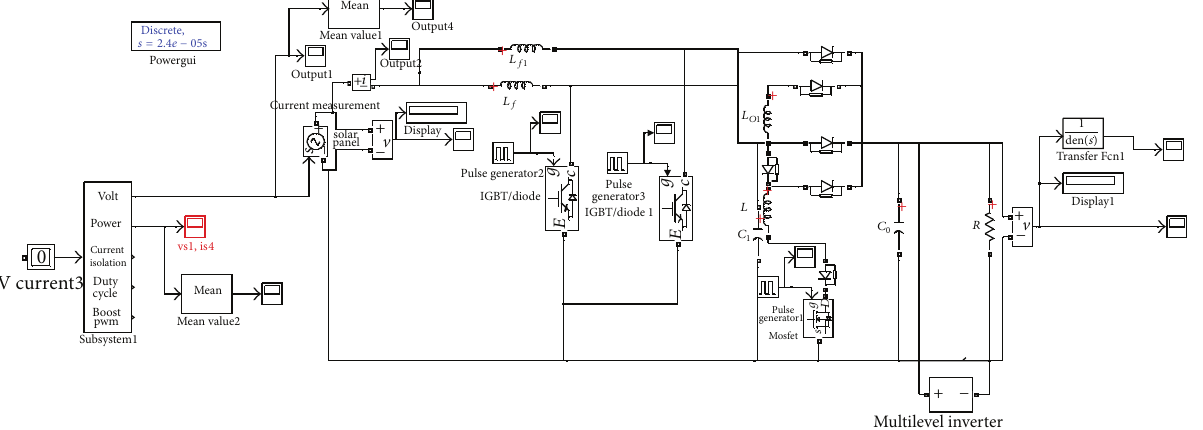
Figure 13: Simulink model of proposed PV based parallel boost converter with active snubber circuit with MLI.